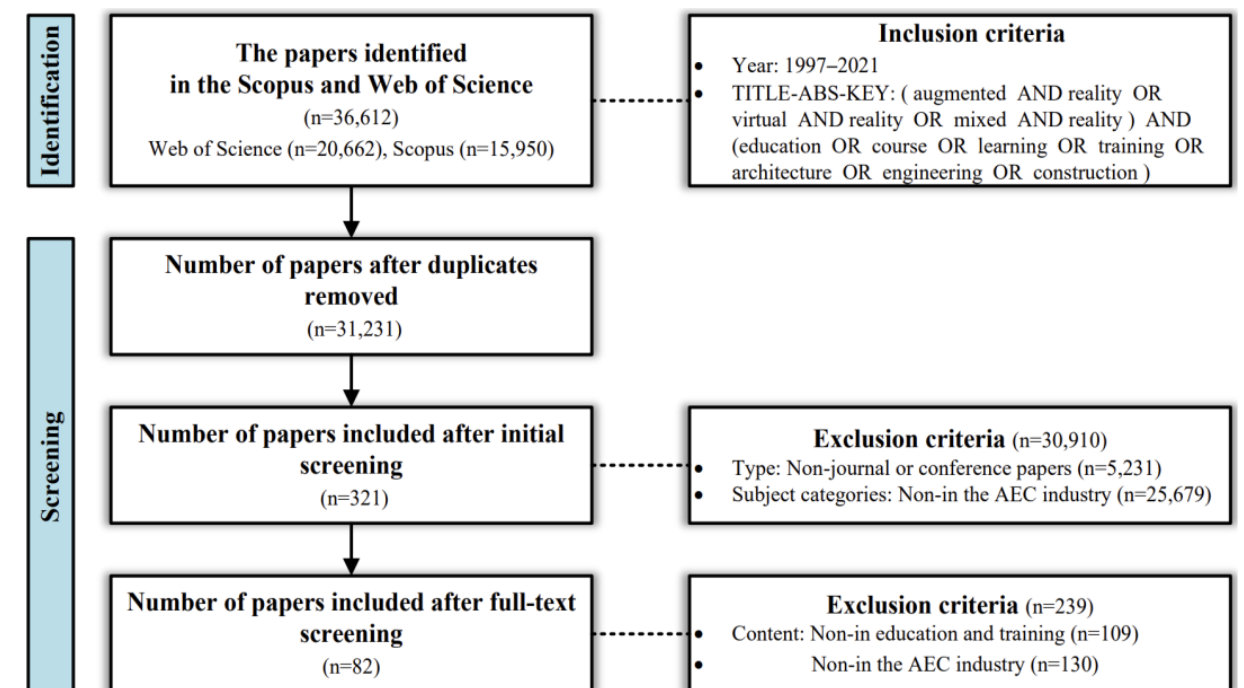
Figure 3. Database literature screening process.